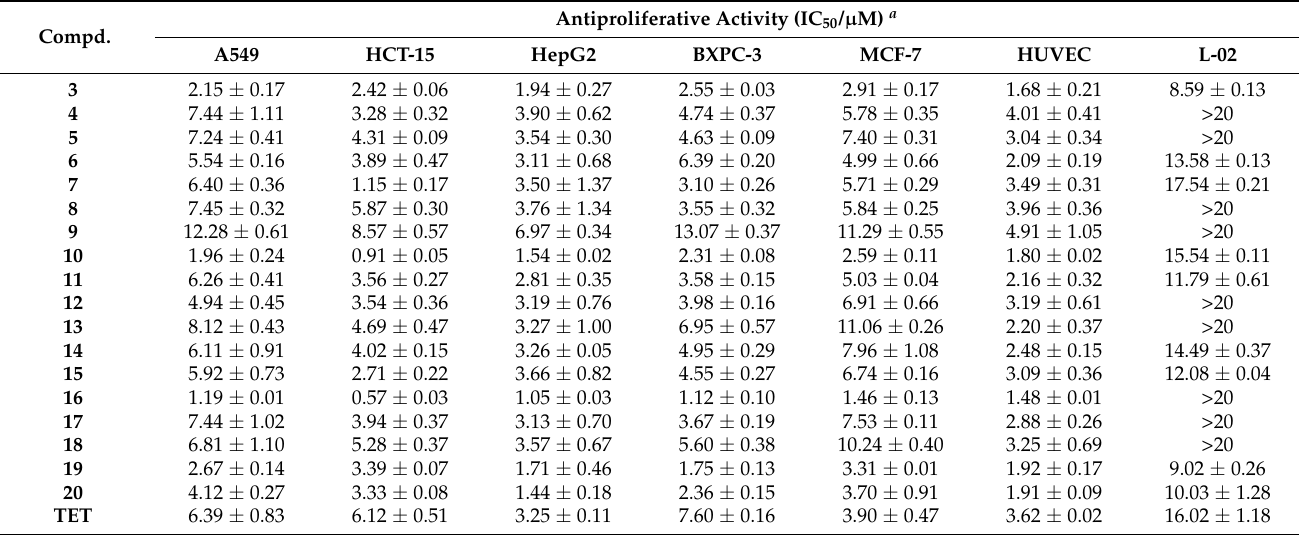
Table 1. Antiproliferative activities of the target compounds against different human cell lines.